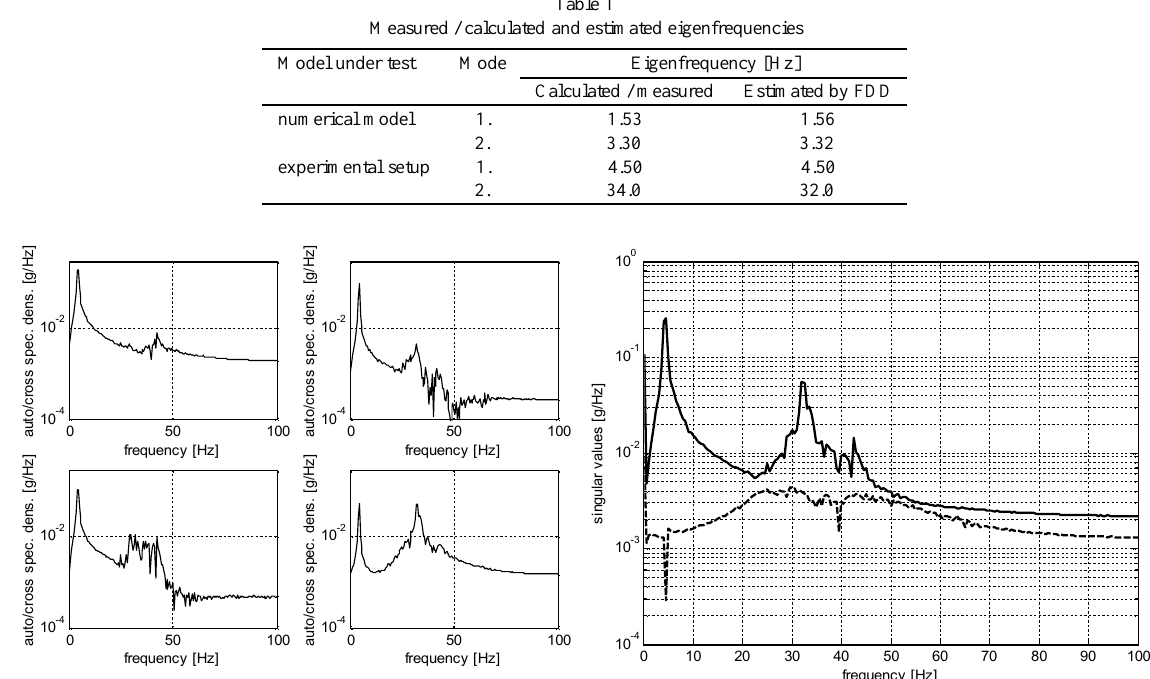
Fig. 12. Auto and cross spectral densities and singular values of experimental